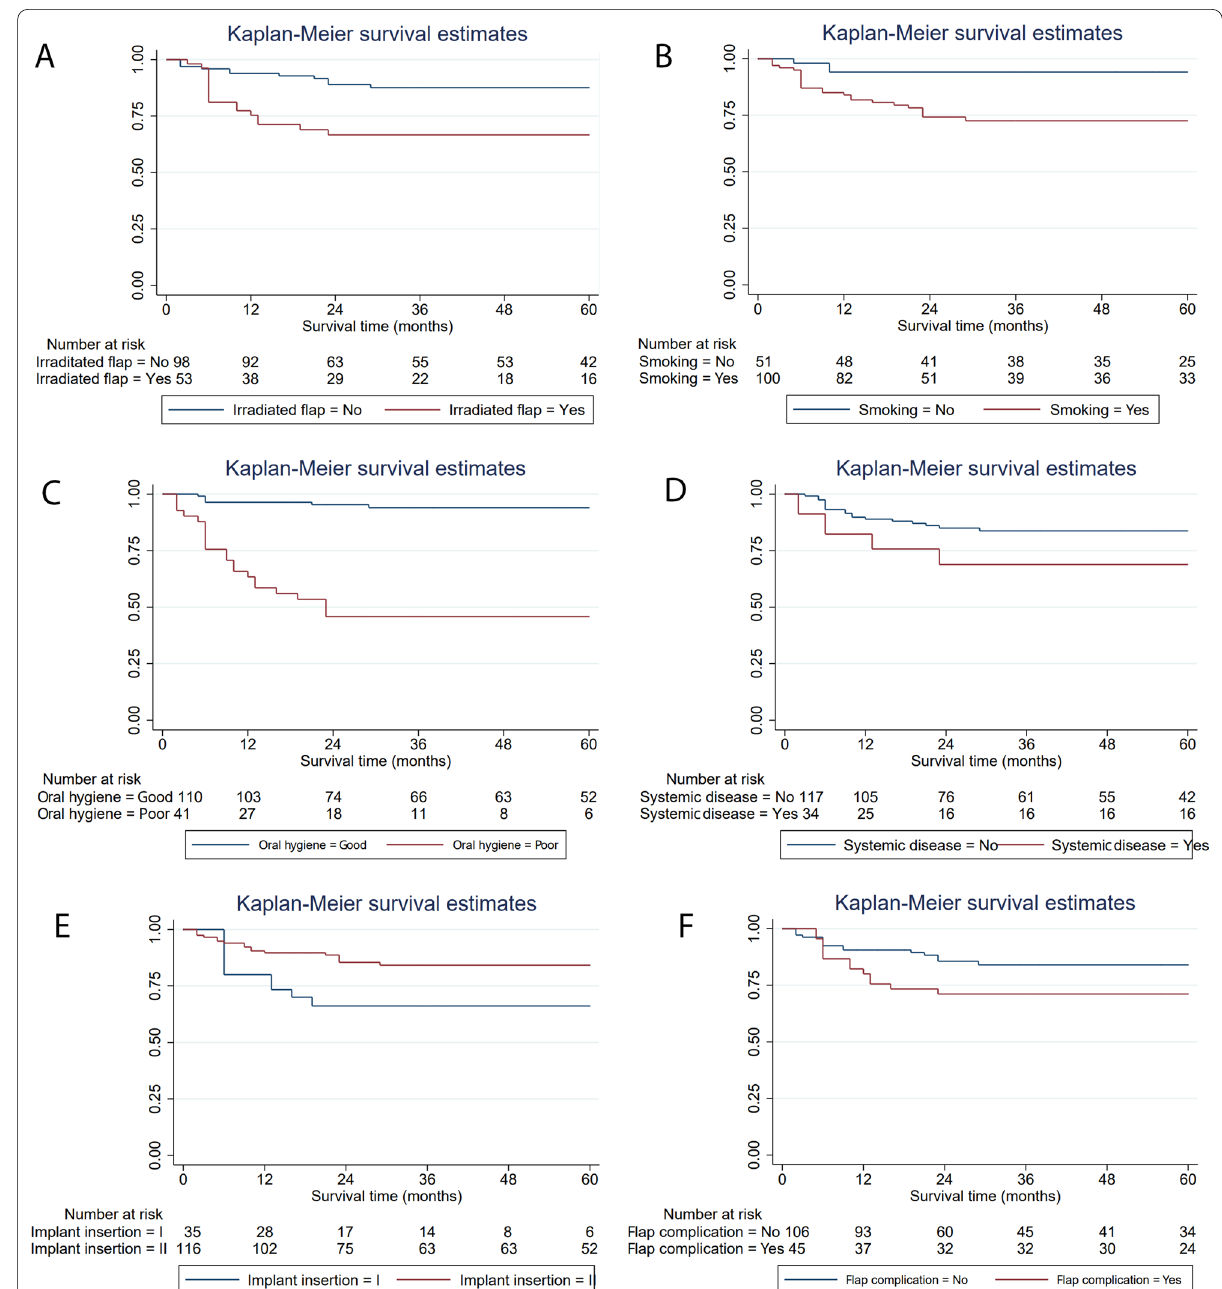
Fig. 4 Kaplan–Meier curves of the 5-year cumulative survival rate in relation to the significant risk factors based on univariate log-rank tests. A Irradiated flap, B smoking; C poor oral hygiene; D systemic diseases; E implant insertion stage; E flap